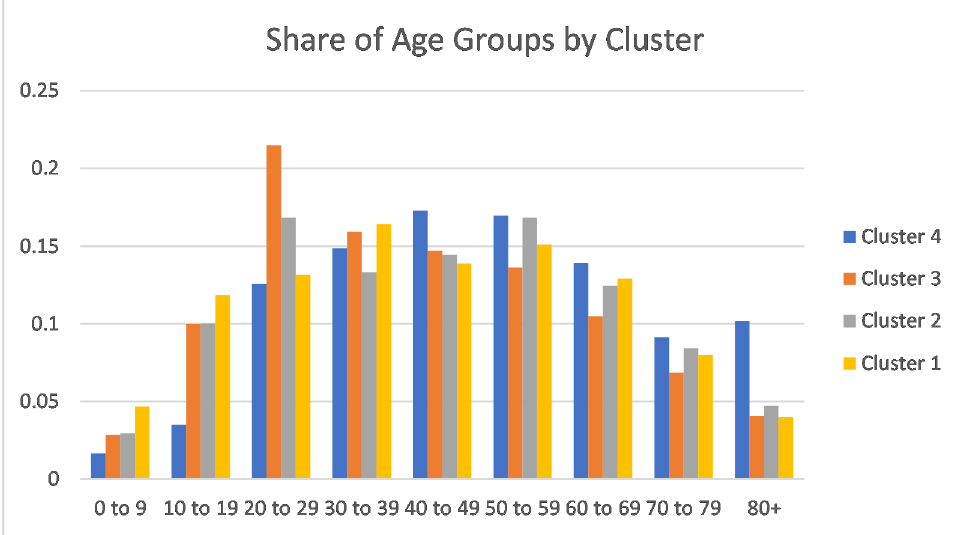
Figure 11. Proportion of individuals for each age group allocated to clusters. Given as a percentage. Cluster 4 was the high-mortality